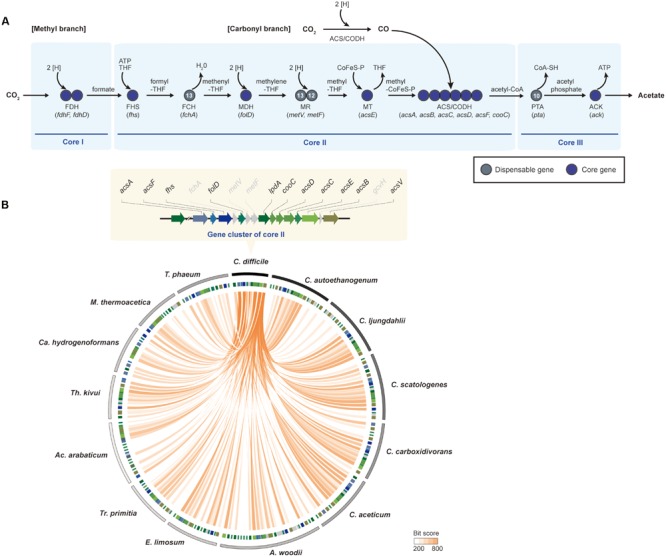
The Wood-Ljungdahl pathway. (A) The methyl- and the carbonyl-branches in the Wood-Ljungdahl pathway. The Wood-Ljungdahl pathway is shown with genes that are represented as core genes (blue circles) and dispensable genes (dark gray circles). The numbers within the circles represent the number of strains that have corresponding genes in other strains. Abbreviations: THF, tetrahydrofolate; CoFeS-P, corrinoid [Fe-S] protein; FDH, formate dehydrogenase; FHS, formyl-tetrahydrofolate synthase; FCH, formyl-cyclohydrolase; MDH, methylene-THF dehydrogenase; MR, methylene-THF reductase; MT, methyltransferase; ACS/CODH, carbon monoxide dehydrogenase/acetyl-CoA synthase; PTA, phosphotransacetylase; ACK, acetate kinase. (B) Comparison of the Wood-Ljungdahl pathway genes between Clostridium difficile 630 and 13 other acetogenic bacteria used in pan-genome analysis. Track 1 (the outermost) represents boundaries of each bacterium. The clockwise order of the genera is based on the phylogenetic tree in Figure 1. Track 2 represents the Wood-Ljungdahl pathway genes, the colors of which are indicated in the upper panel. Orange lines link the genes that have e-values <10-6. Abbreviations: A, Acetobacterium; Ac, Acetohalobium; Ca, Carboxydothermus; C, Clostridium; E, Eubacterium; M, Moorella; T, Thermoacetogenium; Tr, Treponema; Th, Thermoanaerobacter.